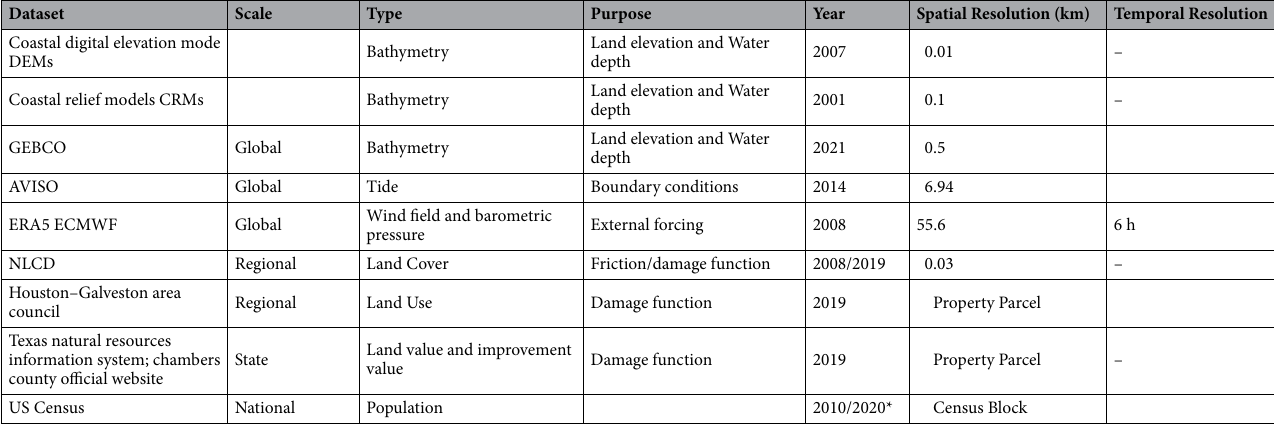
Table 2. Details of different datasets used for modeling storm surge in Delft3D and the economic analyses. Dataset were interpolated to match the points of the model grid domain. The references for the datasets are listed in the SI file. *2020 Census Redistricting